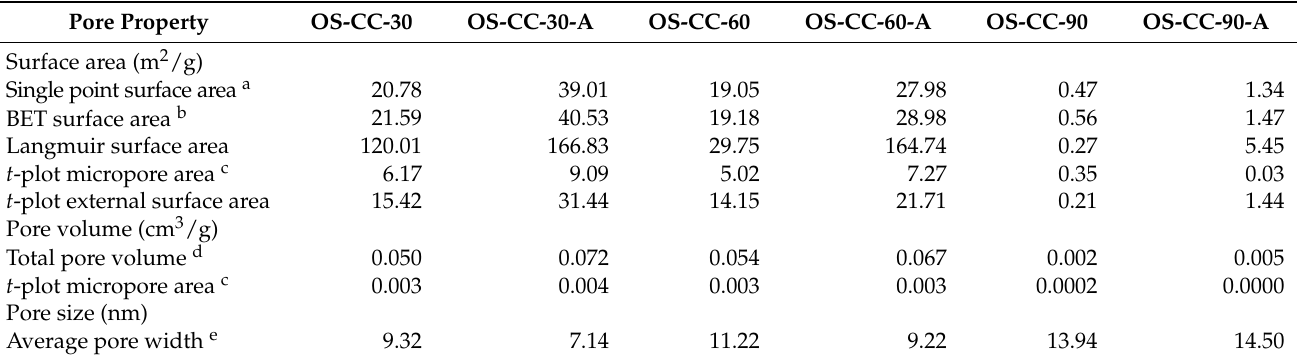
Table 3. Pore properties of the resulting carbon